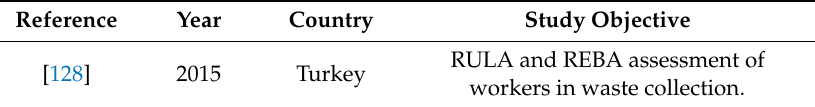
Table 6. Water supply; sewerage, waste management and remediation